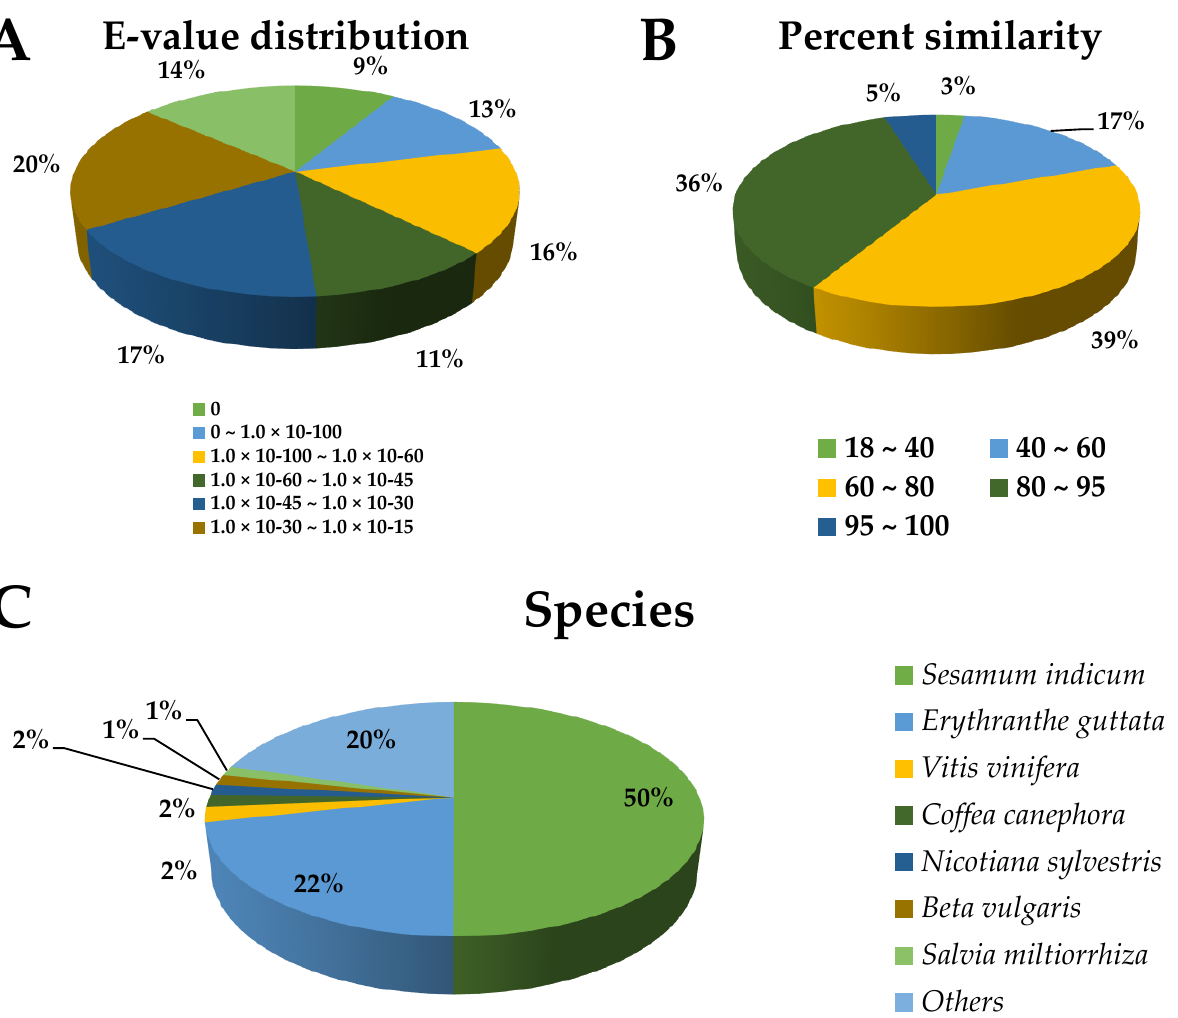
Figure 3. e-value distribution ( A ), percentage similarity ( B ), and species distribution ( C ) of the nonredundant (NR) annotation results for Lavandula pubescens unigenes.